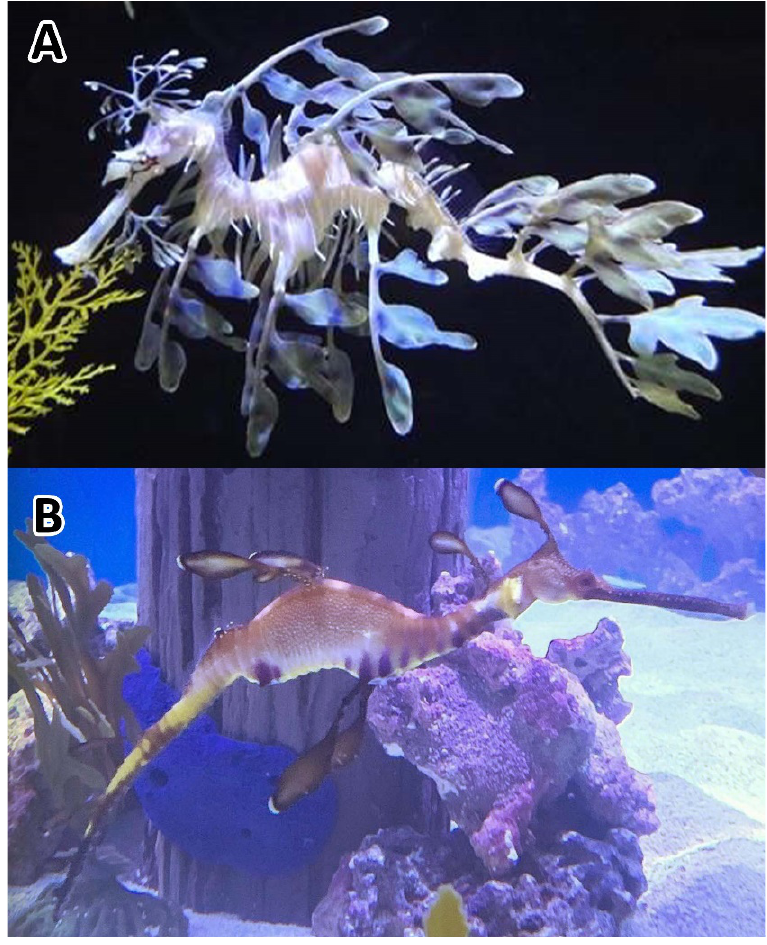
Figure 5. Live photos of captive seadragons. ( A ): leafy seadragon Phycodurus eques in the Birch Aquarium, La Jolla (photo by L. Matsushige). ( B ): common seadragon Phyllopteryx taeniolatus in the Ripley’s Aquarium of Canada, Toronto (photo by M. Warren).